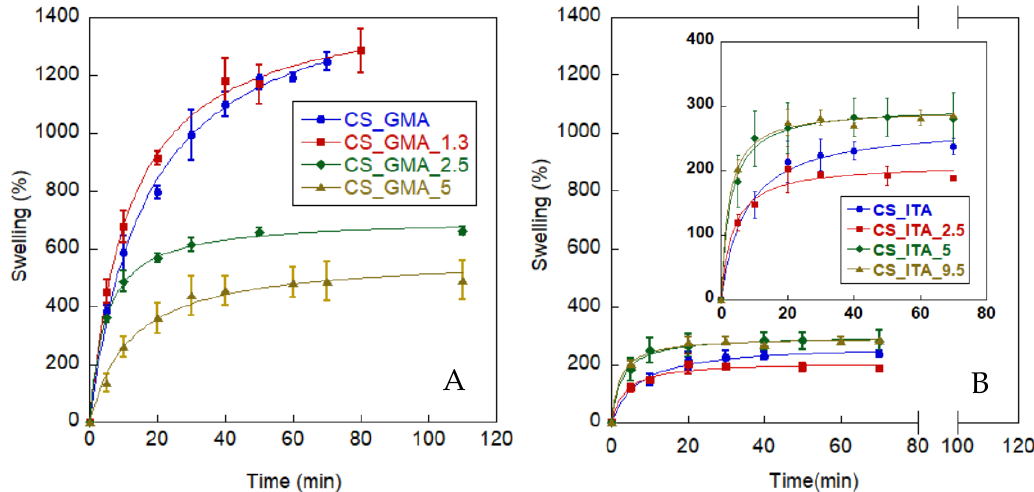
Figure 8. Water uptake kinetics of ( A ) CS_GMA MIPs and NIPs; ( B ) CS_ITA MIPs and NIPs.